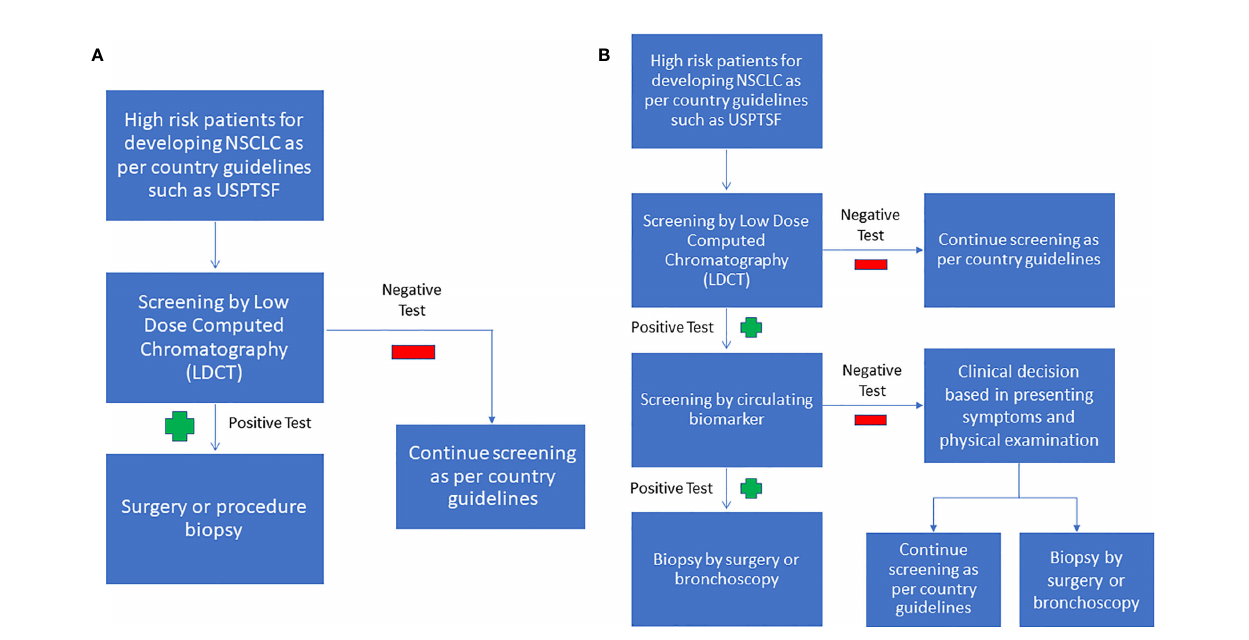
FIGURE 1 | (A) Current NSCLC screening fl owchart (B) Purposed combined screening radiologic imaging with biomarkers. As LDCT is sensitive but unspeci fi c, it can be used as an initial screening test. If the LDCT is positive, the next step we purposed is to use circulating biomarkers to increase the LDCT ’ s speci fi city. If the LDCT is positive, but the biomarker screen is negative, we purpose to base the decision to perform a tissue biopsy on the clinician ’ s